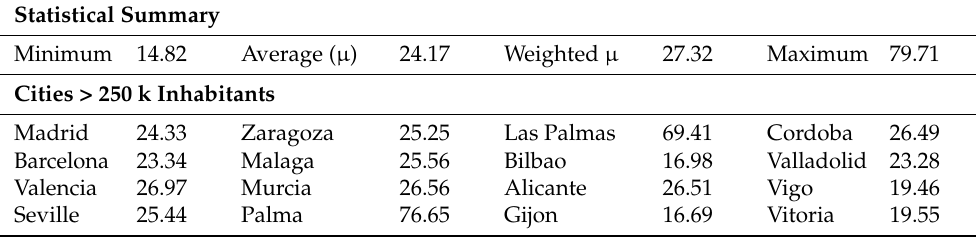
Figure 8. PV ERR in % (S1 (consumption saving scenario) and S2 (surplus sale scenario)). Table 17. PV ERR in % (S1 (consumption saving scenario) and S2 (surplus sale scenario)). Statistical